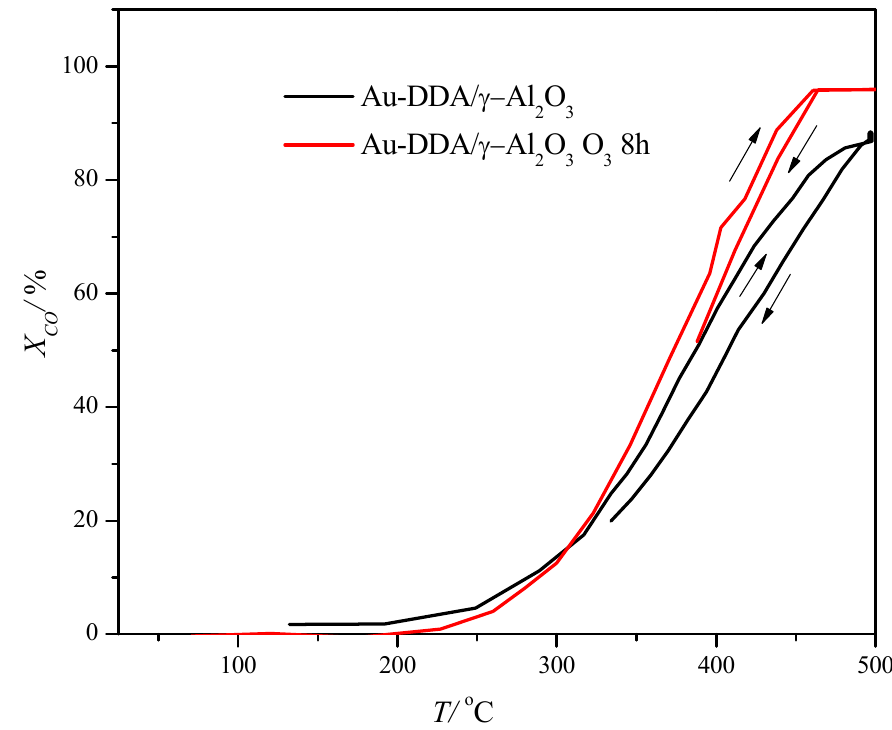
Figure 7. CO oxidation versus temperature during heating and cooling treatment Au-DDA γ -Al 2 O 3 ; and Au-DDA/ γ -Al 2 O 3 (O 3 8 h).